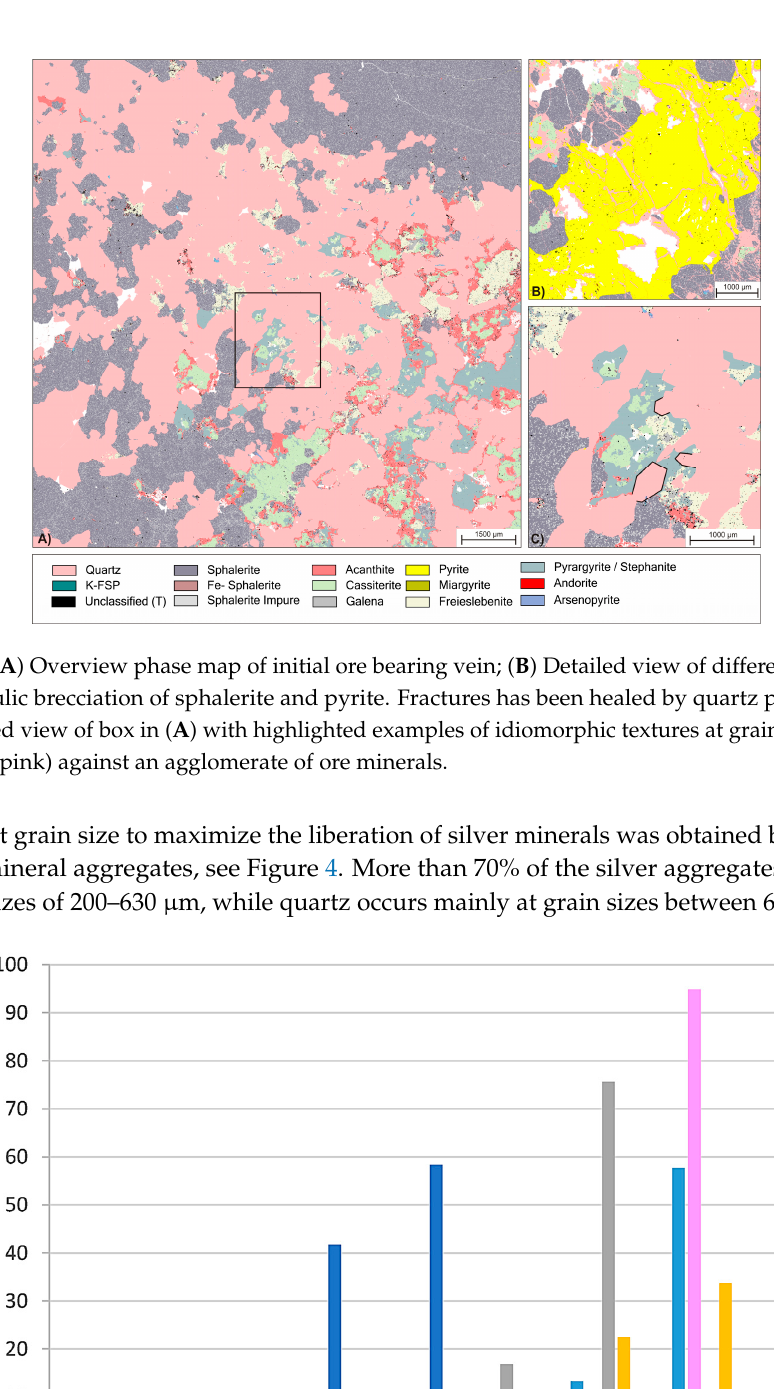
7 of 20 Figure 2. Overview of upscaling procedure. 3. Results and Discussion 3.1. Ore Characterization The characterization revealed important information about the mineral composition, with the results shown in (Figure 3). Petrographicaly, the major silver ore minerals are stephanite (Ag 5 SbS 4 ), pyrargyrite (Ag 3 SbS 3 ), miargyrite (AgSbS 2 ), freieslebenite (AgPbSbS 3 ) and acanthite (Ag 2 S). Low amounts of andorite (AgPbSb 3 S 6 ) also contributes to the silver content. The major ore minerals are accompanied by other sulfides and arsenides like sphalerite (ZnS), pyrite (FeS 2 ) and different kinds of the löllingite-rammelsbergite-safflorite group. Quartz (SiO 2 ) and potassic-feldspar (KAlSi 3 O 8 ) are